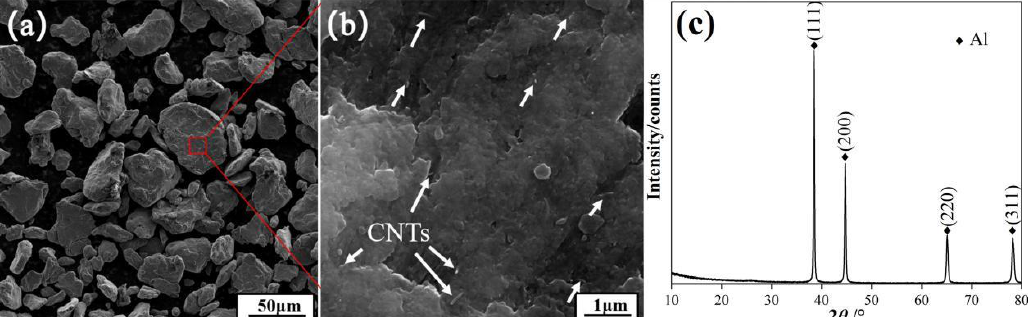
Figure 3. The microstructure and phase composition of milled CNTs/Al nanocomposites powders. ( a , b ) CNTs/Al; ( c ) XRD patterns of CNTs/Al.